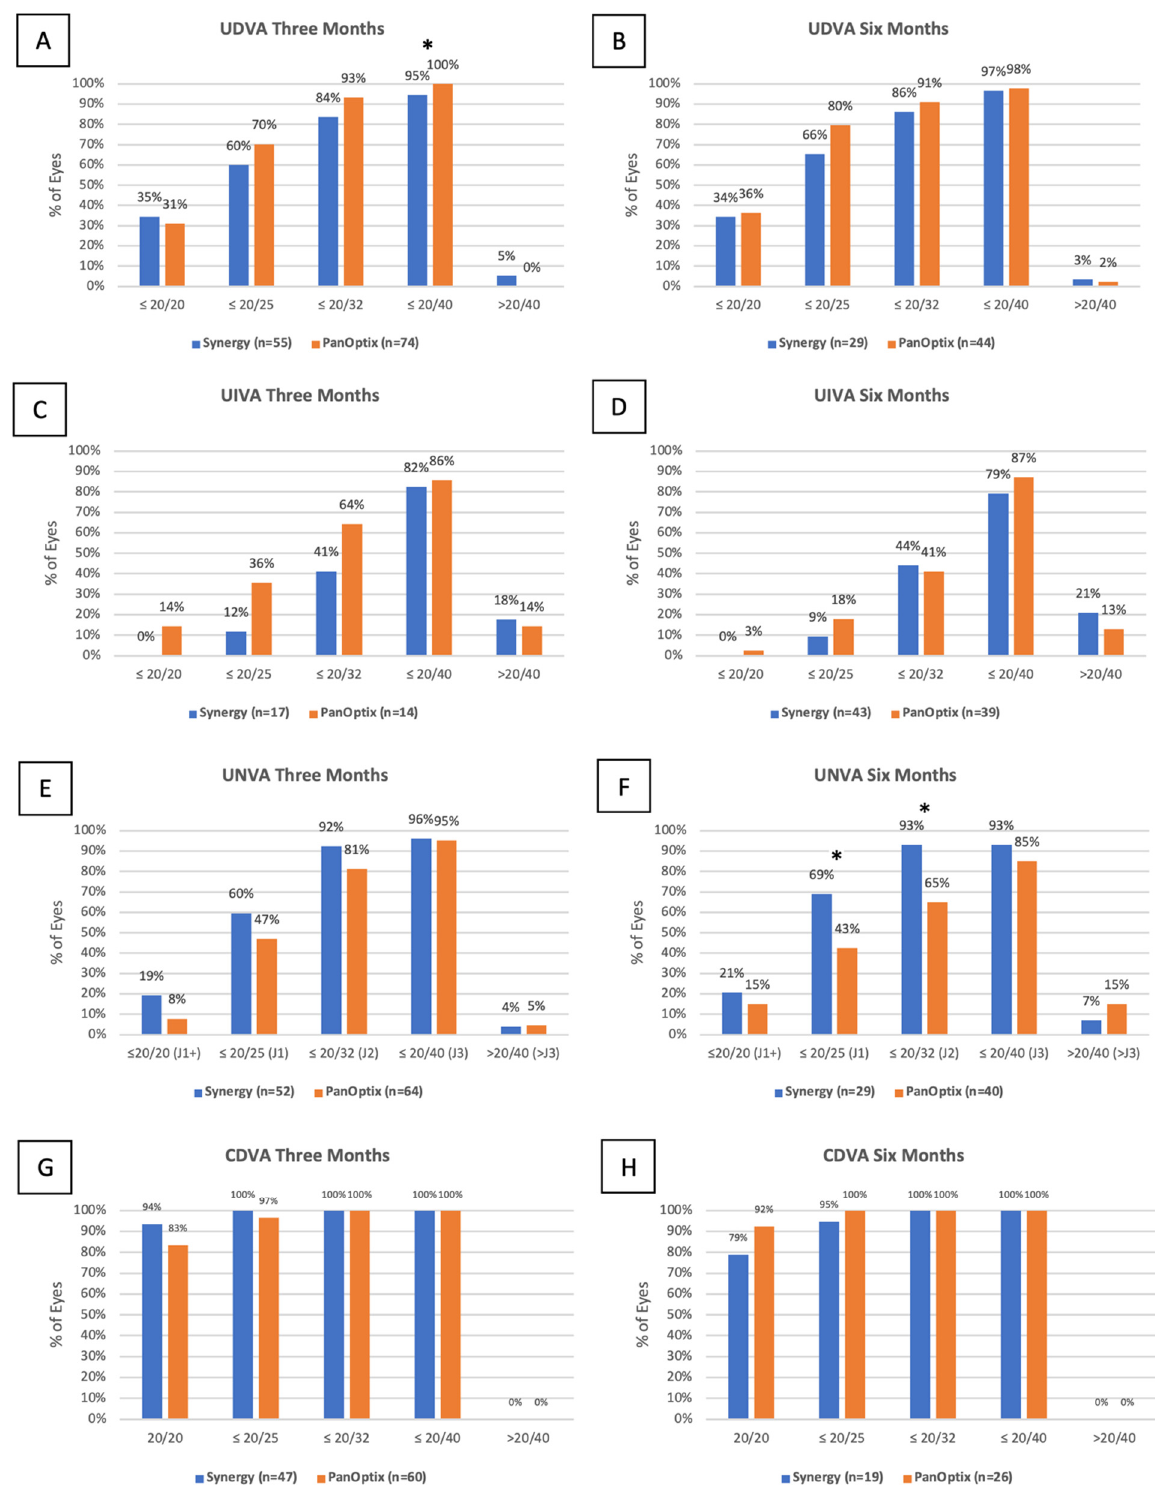
Figure 1. Distribution of monocular UDVA ( A , B ), UIVA ( C , D ), UNVA ( E , F ) and CDVA ( G , H ) visual acuity at three months and six months in the TECNIS Synergy and AcrySof IQ PanOptix groups. (* = statistically significant interval).